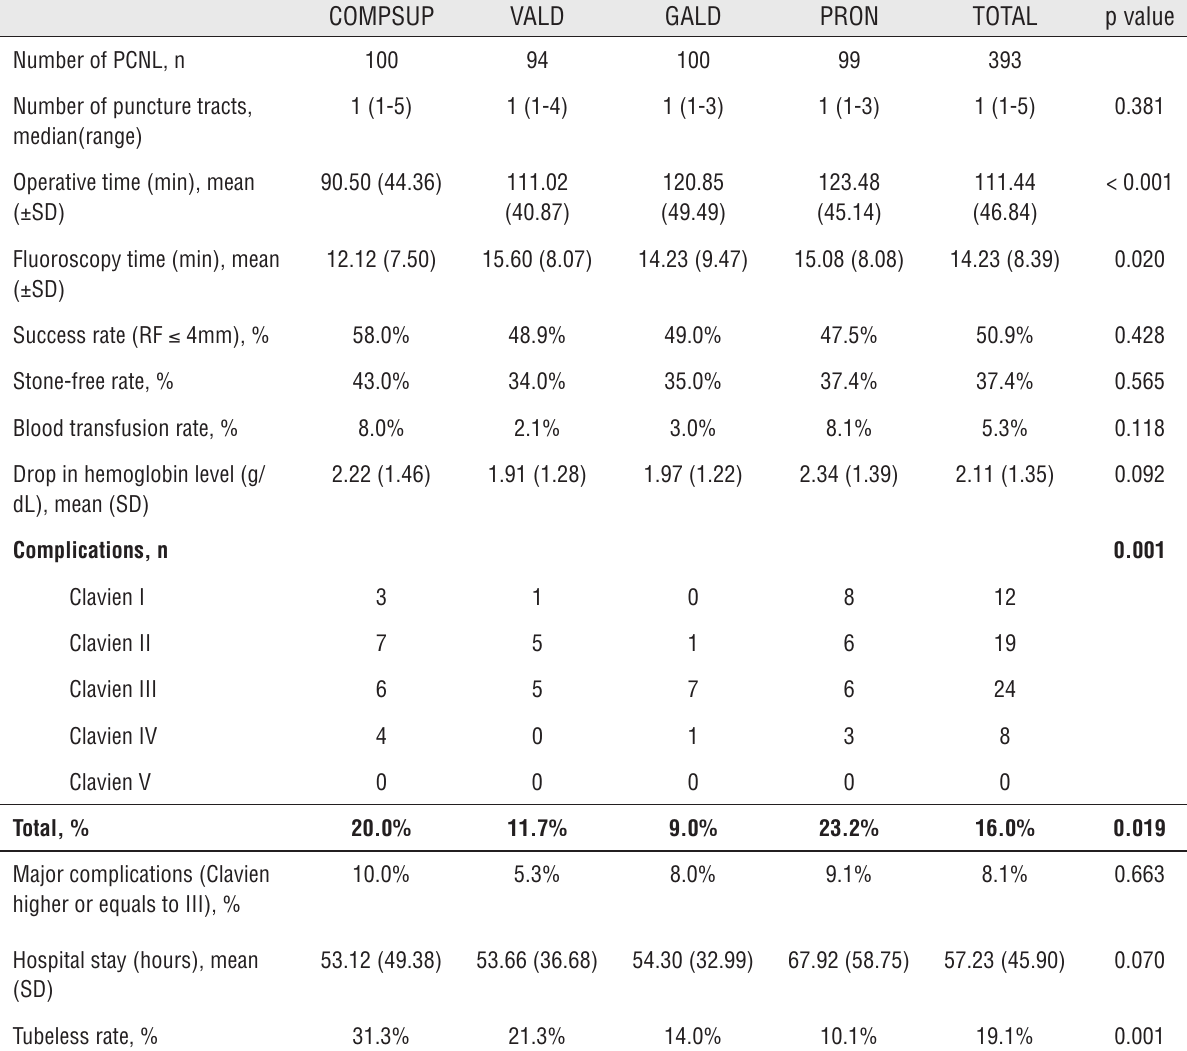
Table 2 - Peri-operative results in different positions.